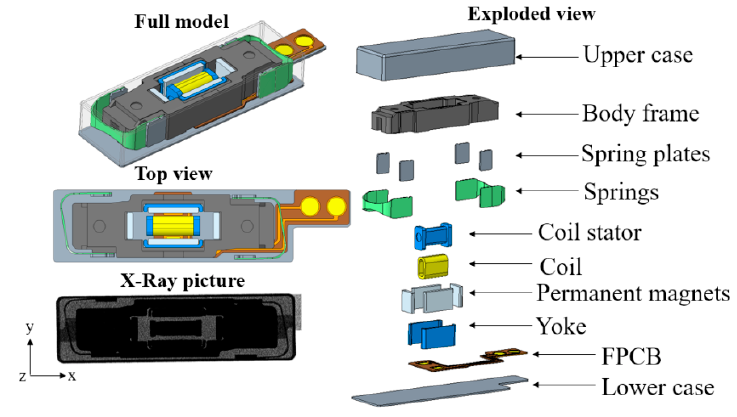
Figure 3. Hybrid linear motor.